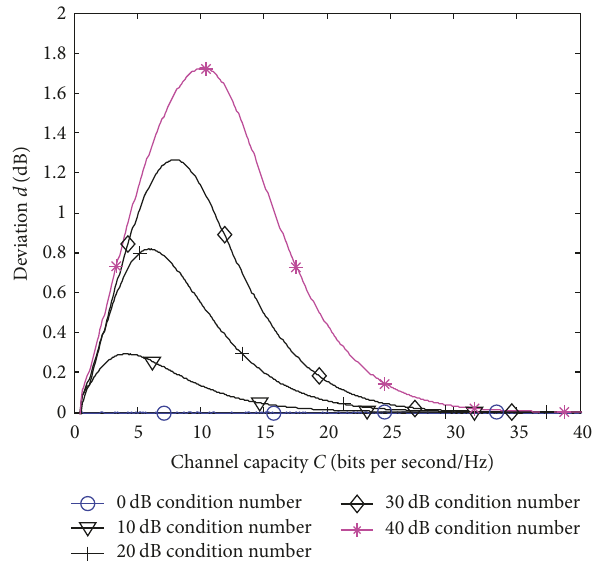
Figure 9: Deviation 𝑑 versus absolute channel capacity 𝐶 using DM = {0 dB ,10 dB , 20 dB , 30 dB ,40 dB } for 𝜅 H ant